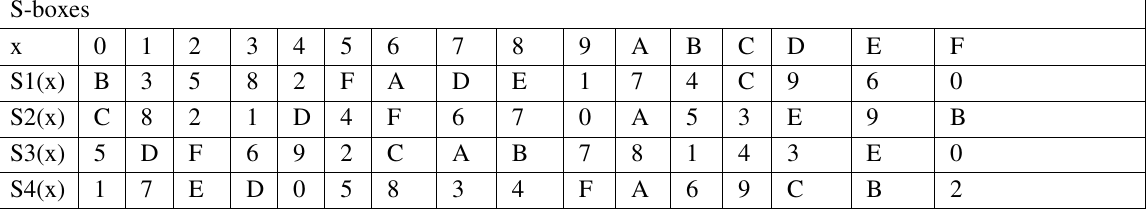
Table 1. The S-boxes of SLEA